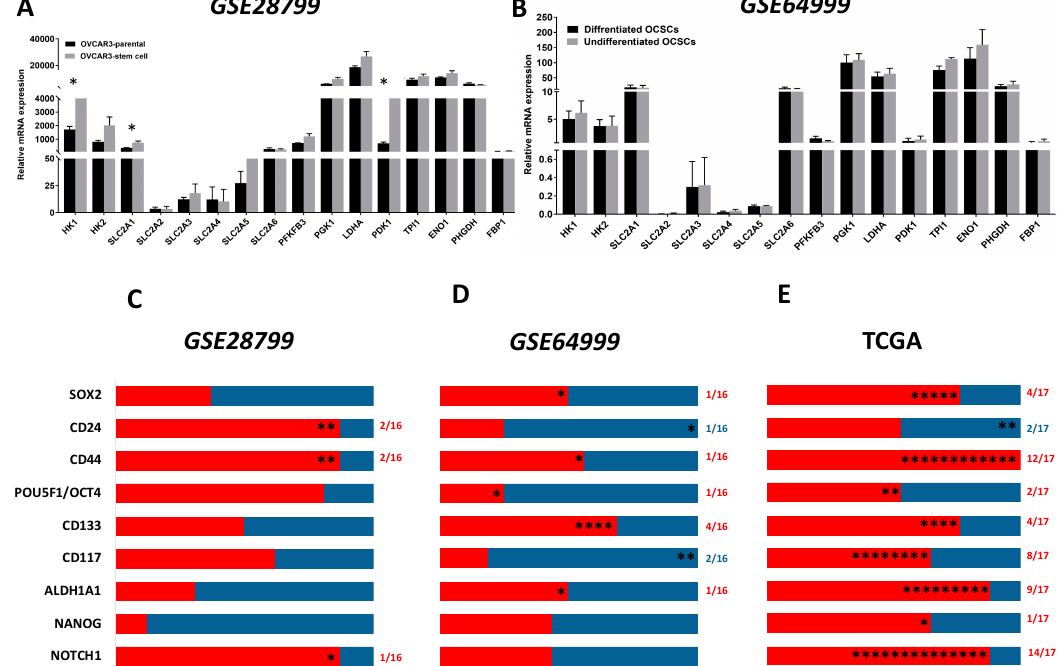
Figure 3. Expression of glycolysis markers in GSE28799 and GSE64999: ( A , B ) Bars represent mean ± SEM of the relative mRNA expression of the indicated glycolytic enzymes in OVCAR3 stem-cells vs. their parental cells in GSE28799, and undifferentiated vs. differentiated OCSCs in GSE64999 , respectively. Significance was determined using multiple t -test and Holm–Sidak method with each row analyzed individually with p < 0.05, without assuming a consistent SD. ( C – E ) Bar graphs represent the prevalence of positive ( red ) and negative ( blue ) correlations of the indicated markers in OVCAR3-spheroids and the glycolytic enzymes in Supplement Tables S1–2 and Table 1. * indicates the number of significant correlations either positive or negative.